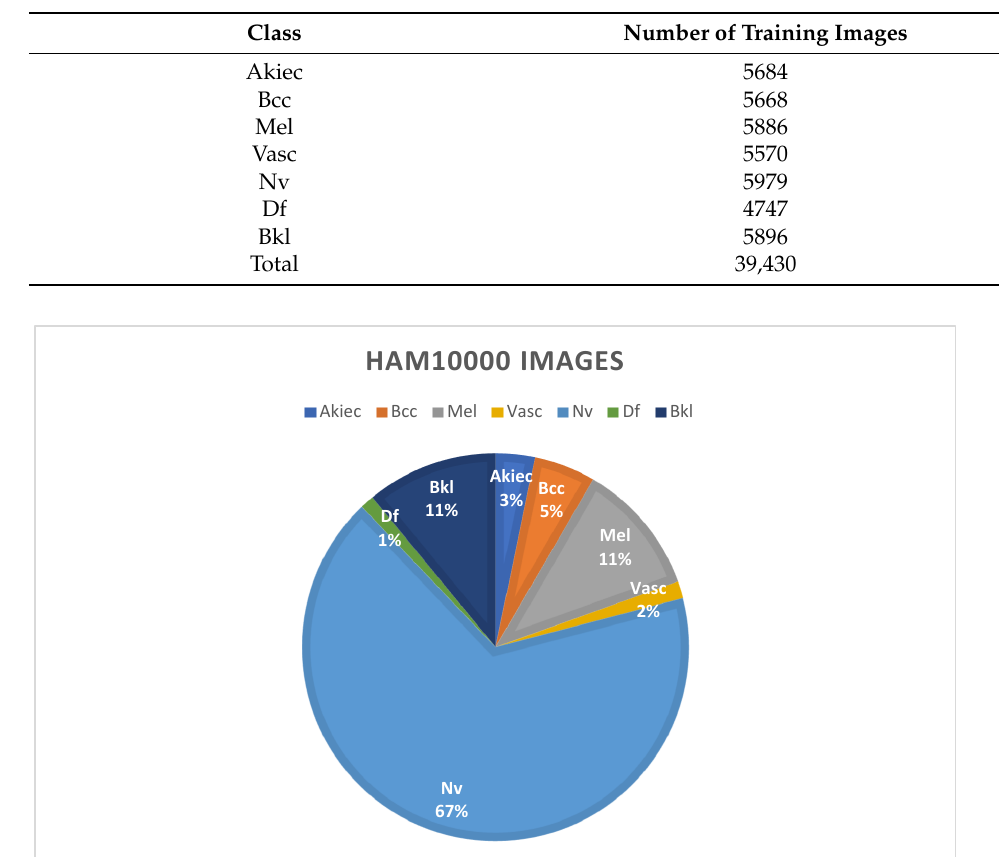
Figure 8. Balanced dataset after applying augmentation techniques. 3.2.4. Learning Models This section describes the basic theory of the adopted approaches, and the proposed DL approach is presented in the next sections.